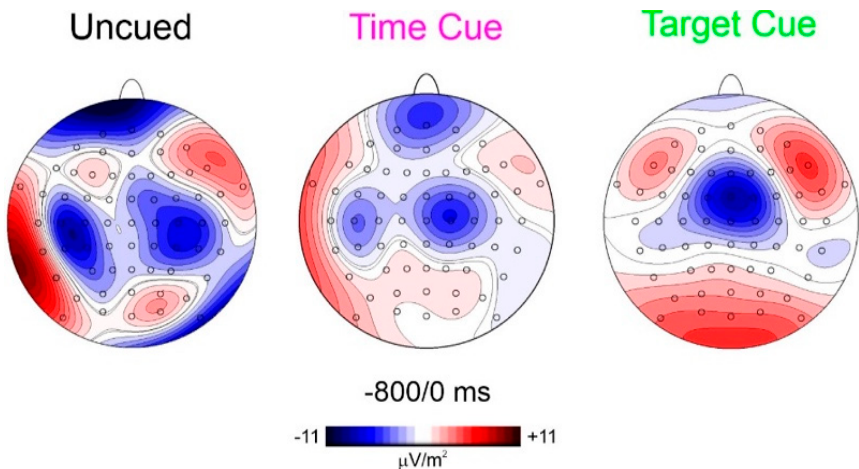
Figure 4. CSD scalp distribution in the window from − 800 to 0 ms shows the presence of prefrontal activity with different gradients.